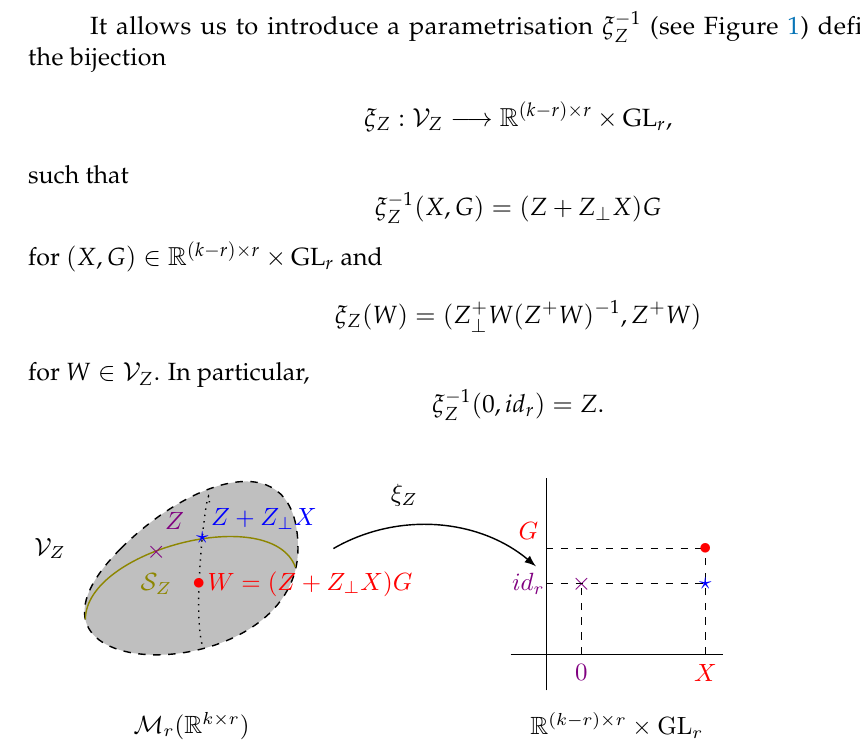
( R k × r ) ( R k × r ) , X ) G X ) G ∈ V Z ⊂ M r ∈ V Z ⊂ M r ⊥ ⊥